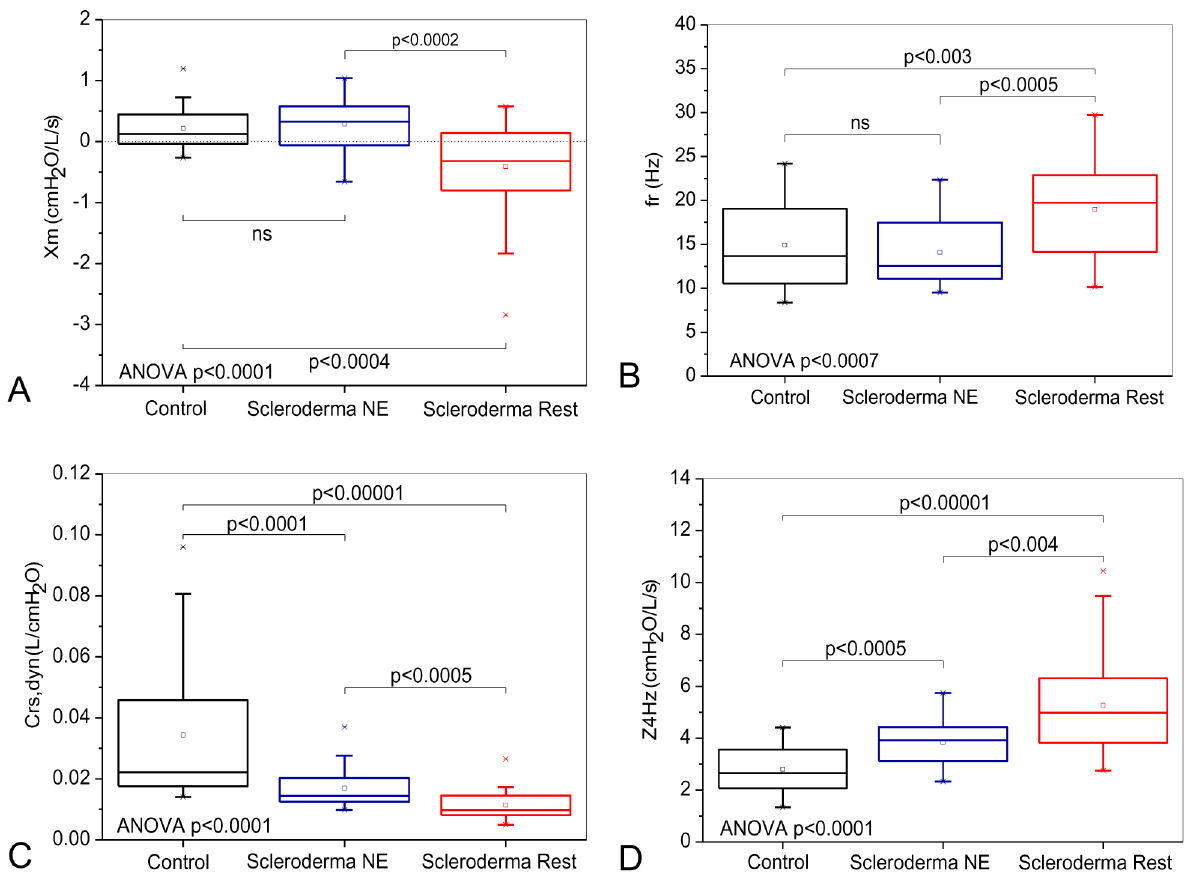
Figure 3. Influence of the pattern classified as restrictive in the spirometric exams on the reactive properties of the respiratory system. Mean reactance (Xm; Figure A) and the dynamic compliance of the respiratory system (Crs,dyn; Figure B) decreased, whereas the resonant frequency (fr; Figure C) and the impedance modulus at 4 Hz (Z4Hz; Figure D) exhibited significant increases. Notably, there are significant alterations in Crs,dyn and Z4Hz even in the patients classified as normal (Figures C and D).